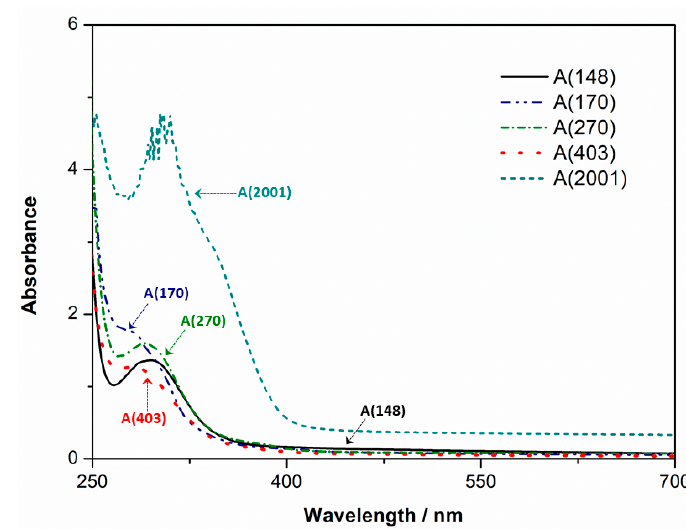
Figure 3. UV-visible absorption spectra normalized for the thickness of each xerogel film, namely A(148), A(270), A(403), A(170), and A(2001).